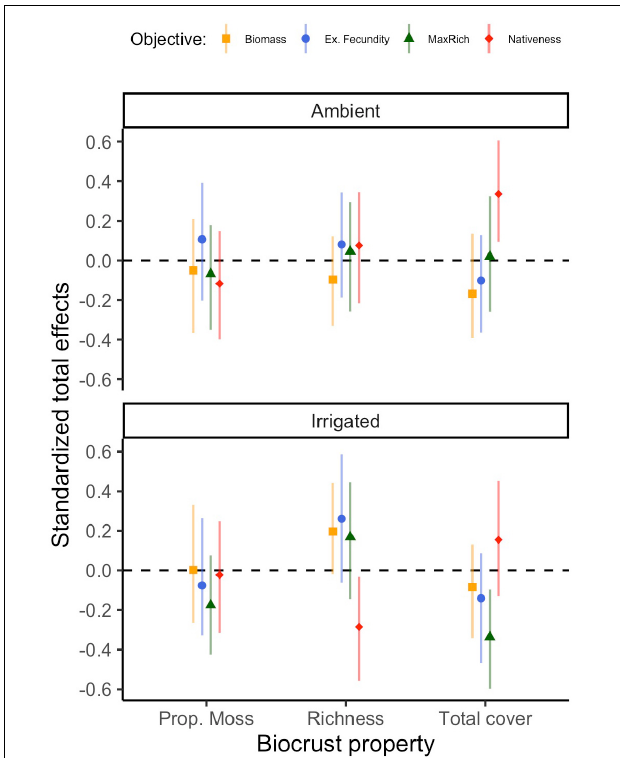
FIGURE 5 | Standardized total effects of biocrust properties on management outcomes through time, under ambient and irrigated conditions. Estimates of these effects differ very slightly ( ≤ 0.009) across model runs in different time points, therefore the mean effect and its mean bootstrapped 95% confidence interval (based on 500 bootstrap samples) are plotted. Because total effects of composite variables cannot be computed, the effect of biocrust condition is